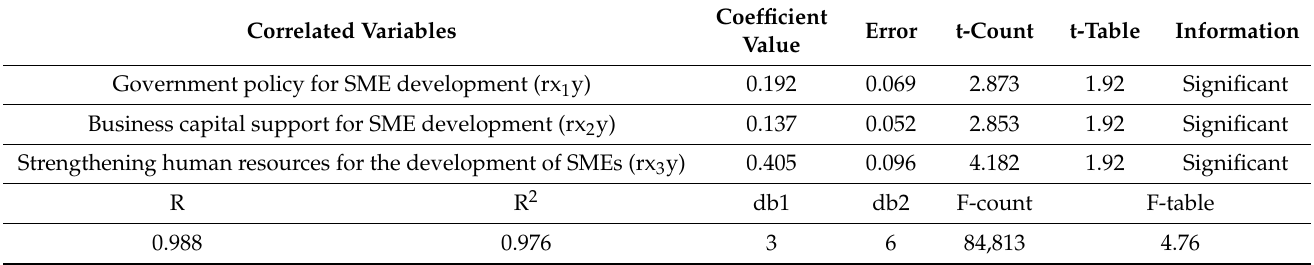
Table 6. A summary of the test results for the significance of the regression equation coefficient. Correlated Variables